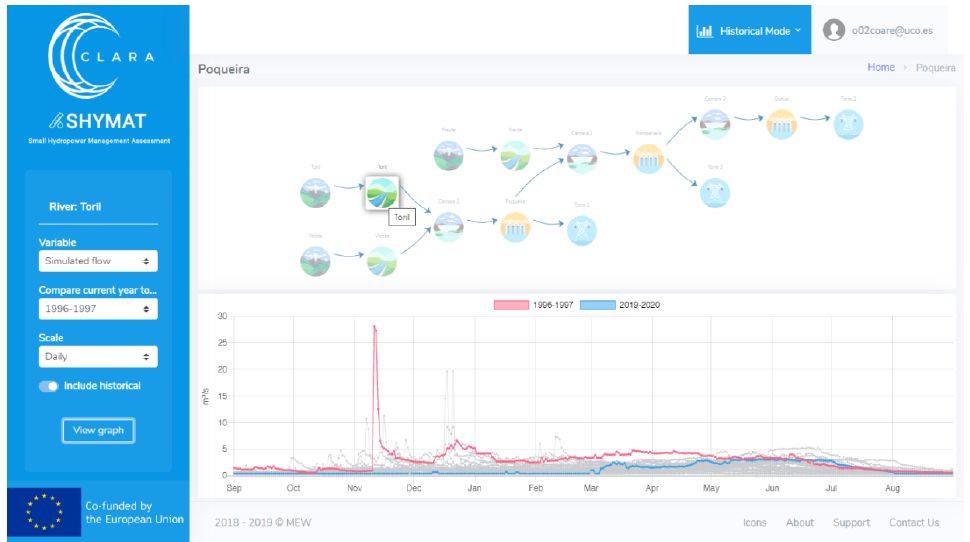
Figure 5. Example of visualization of the SHYMAT web-user interface. Historical mode outputs: The river element is selected in the topology panel and a graph showing the daily streamflow data for the hydrological years 1996/97 (red) and 2019/20 (blue), and for the period 1981–2020 (grey) appears on the screen.